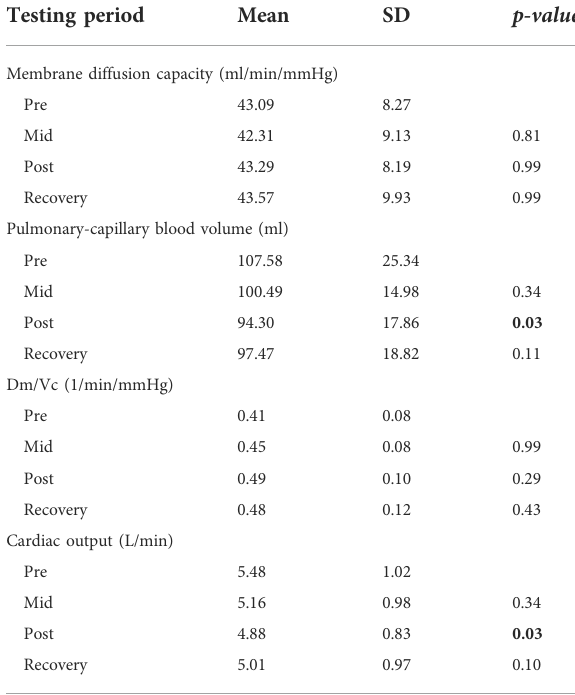
TABLE 3 Thein fl uenceof30 s,60 s,and120 soscillationsof80/20and 30/70 O 2 /N 2 concentrations on cardiac output. Testing period